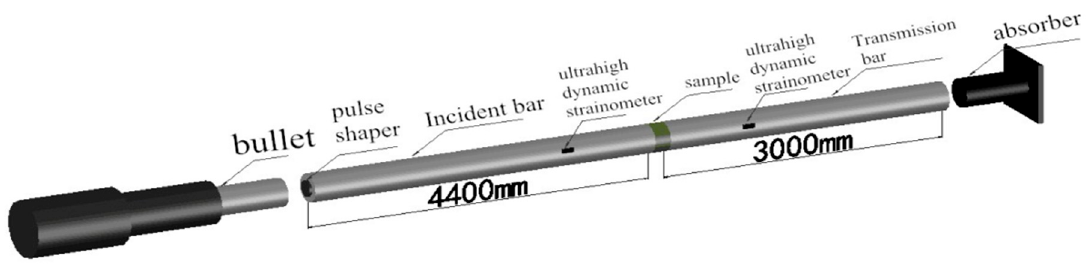
Figure 3. SHPB test system structure.